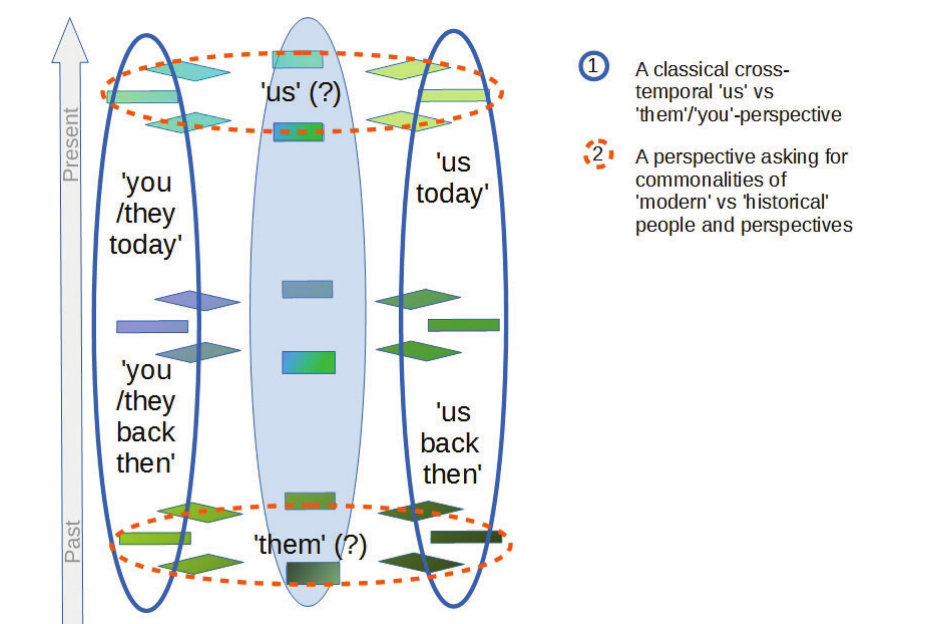
Figure 2: Two different forms of addressing a historical